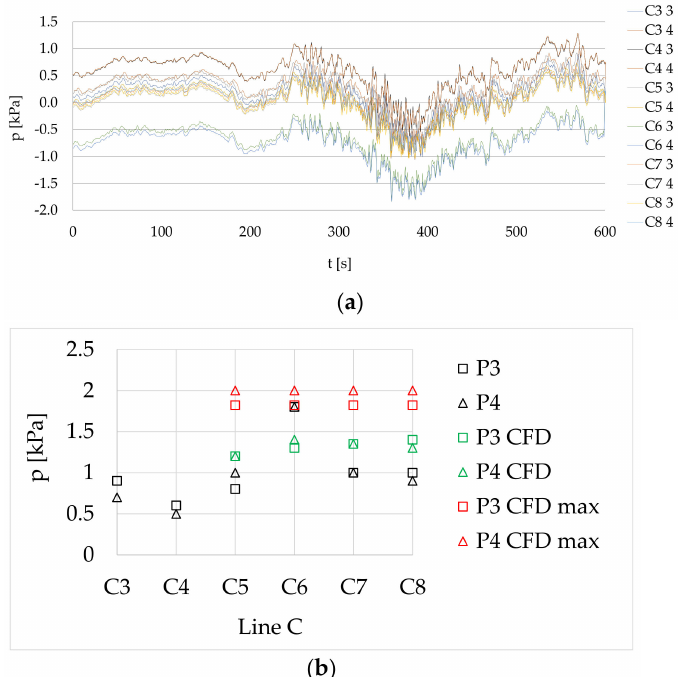
Figure 8. Pressure during the berthing: ( a ) real measurements collected during the berthing of Ferry 2; ( b ) maximum absolute values of pressure: P3, P4—measurements during the berthing of Ferry 2 in the C3–C8 lines using the pressure meters P3 and P4; P3 CFD and P4 CFD—results of the CFD simulation with both the bow thrusters operating with 105 kN thrust each during the period of time of 5 s; P3 CFD max and P4 CFD max–maximum single pressure pulses.